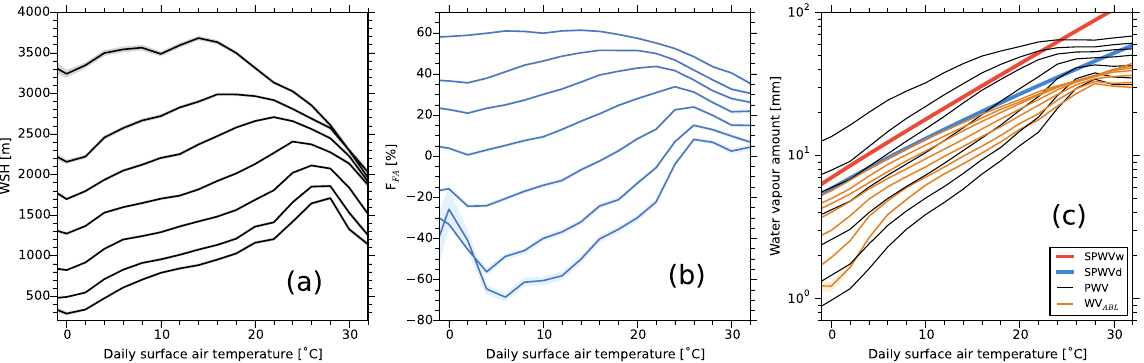
Figure 3. Percentiles of water vapour parameters as a function of SAT. ( a ) WSH. ( b ) Percentage of water vapour amount in the free atmosphere (F FA ). ( c ) Water vapour amount in the boundary layer (WV ABL ; orange), GPS- PWV (black), SPWV w (bold red) and SPWV d (bold blue). Multiple lines of WSH, F FA , and WV ABL represent the values when the 99th, 90th, 75th, 50th, 25th, 10th and 5th percentiles values of GPS-PWV (from top to bottom in the figures) are observed. In panel ( c ), the GPS-PWV percentiles are the same as in Fig. 2a except for the number of stations used. The shaded area indicates the 90% confidence intervals (see Methods). Note the vertical log scale in ( c